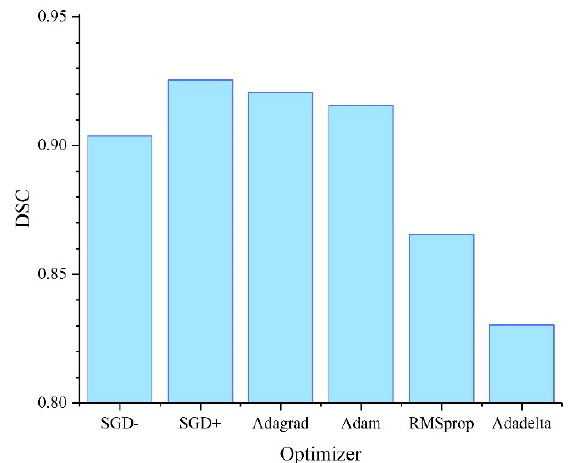
Figure 4. Accuracy of damage detection on test images depending on the optimizer selected during the training of the U-Net neural network with a ResNet152 backbone.